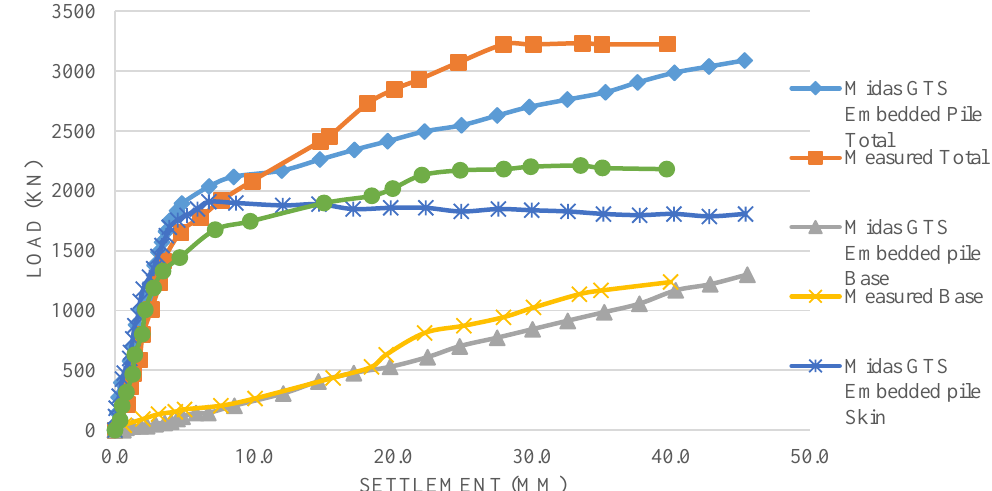
Fig. 14. Calibration and validation of skin resistance and base resistance for embedded piles model using the load-settlement curve of the pile loading test.